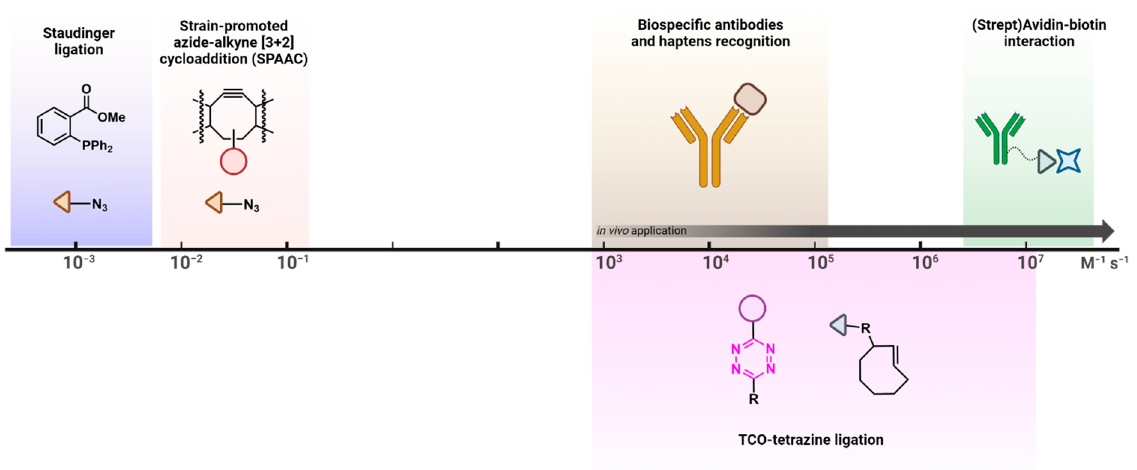
Figure 1. Comparison of state-of-the-art bio-orthogonal reactions with respect to their kinetics. Rate constants (k2) are reported. Reported values are measured in aqueous solution at a 1 µM concentration of both probes.